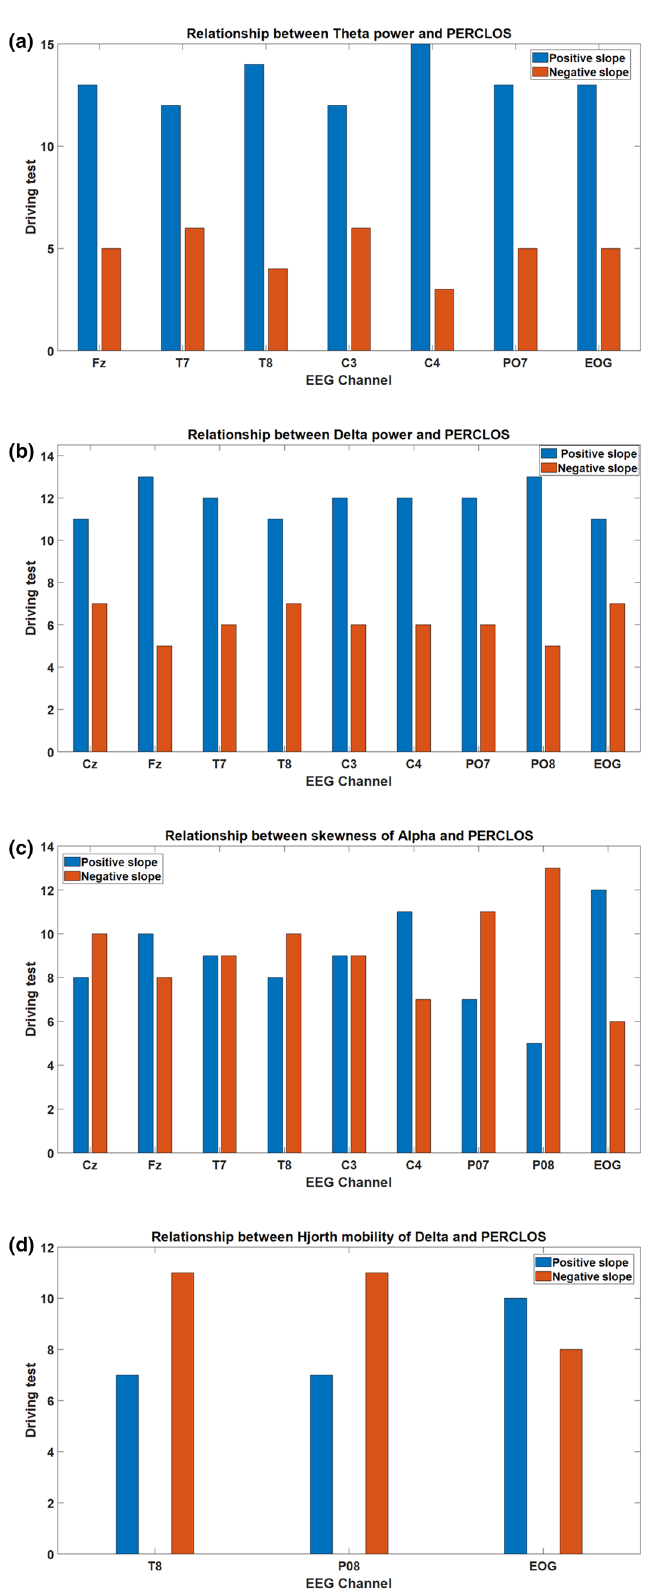
Figure 8. Slope signs of the biomarkers in different driving tests that are statistically significant. According to these results, discovered biomarkers make a ‘push-pull mechanism’ to estimate the driver